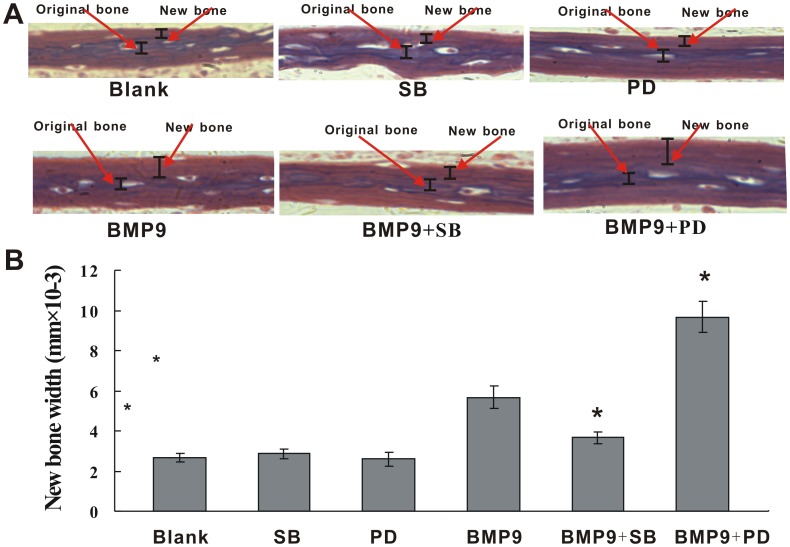
Opposing effects of p38 and ERK1/2 on BMP9-induced new bone formation in calvarial organ culture.(A) Mouse calvariae was infected with Ad-BMP9, and then treated with SB203580 (25 µM) and PD98059 (10 µM). At 4 days post infection, calvariae was placed into fresh media and return to incubator for another 3 day until day 7. The amount of original bone remaining and new bone was assessed by H&E staining. Magnification, ×600. (B) measurement of new bone width using Image Pro Plus. “*”, p<0.05 (vs. BMP9).